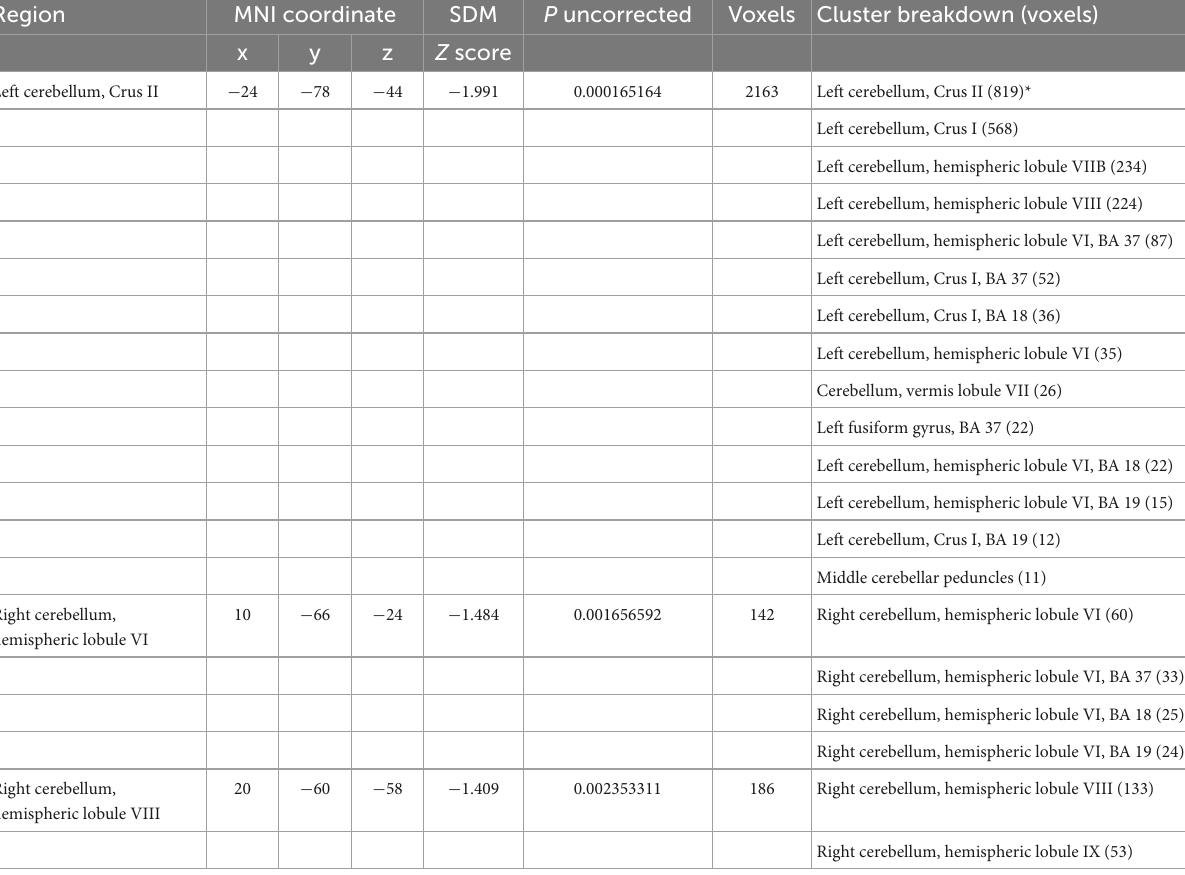
TABLE 1 Gray matter volume changes between patients with schizophrenia and healthy controls (25 studies). Region MNI coordinate SDM P uncorrected Voxels Cluster breakdown (voxels) x y z Z score Left cerebellum, Crus II −